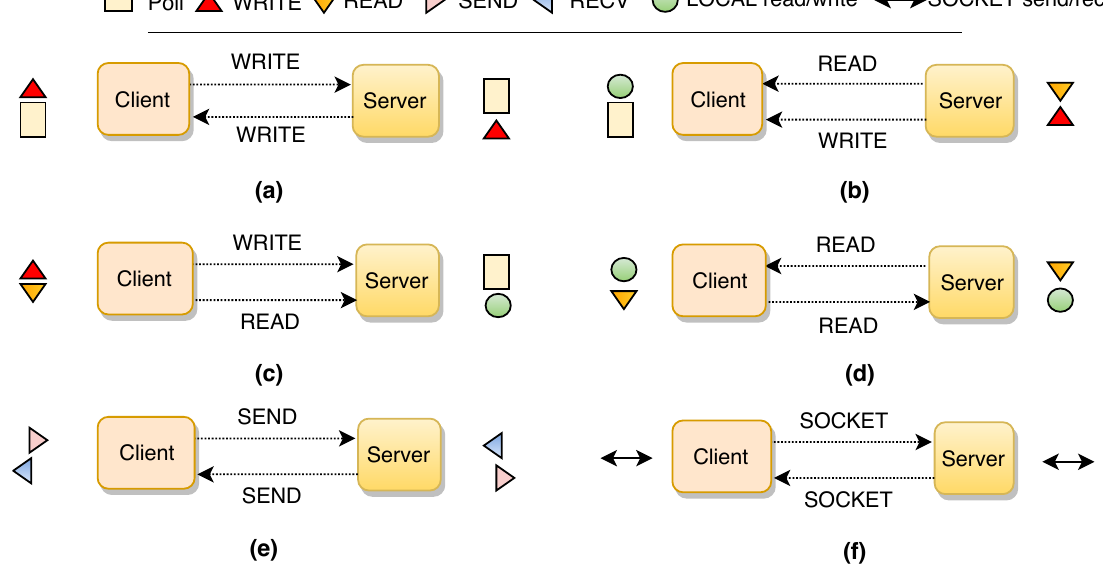
Figure 4. Communication paradigms.